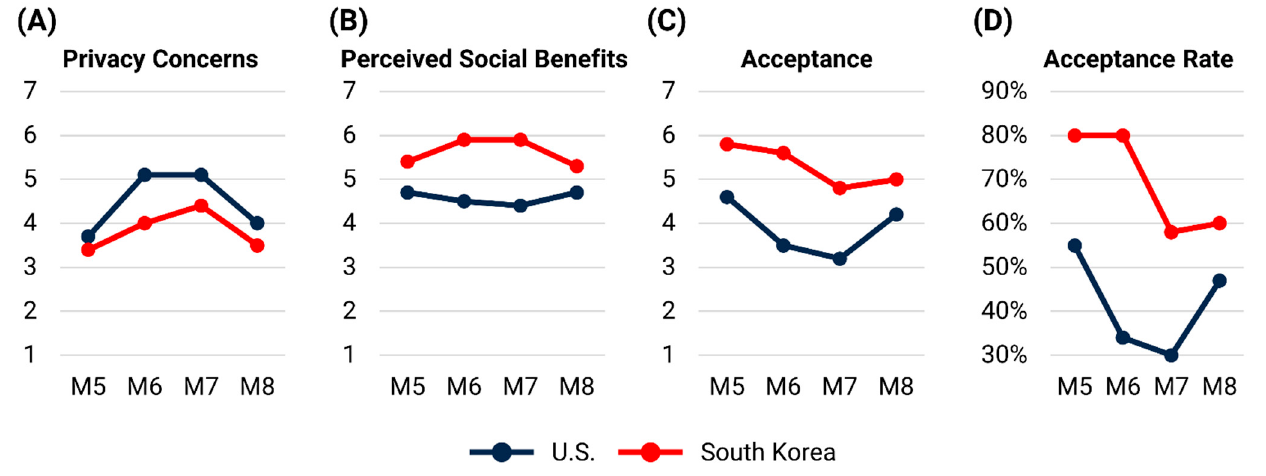
Figure 4. ( A ) Average privacy concerns; ( B ) Average perceived social benefits; ( C ) Average acceptance ( D ); Acceptance rate (M5–8).